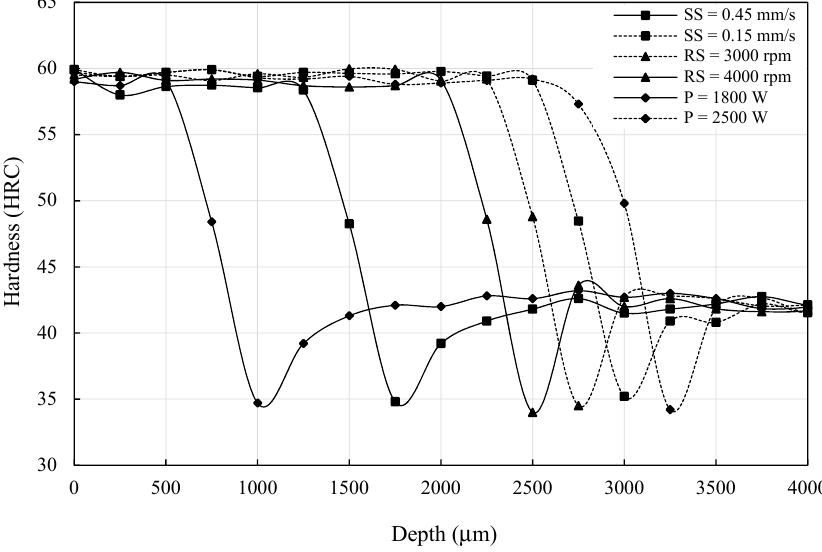
Figure 7. Typical hardness curves for gear teeth top versus process parameters.